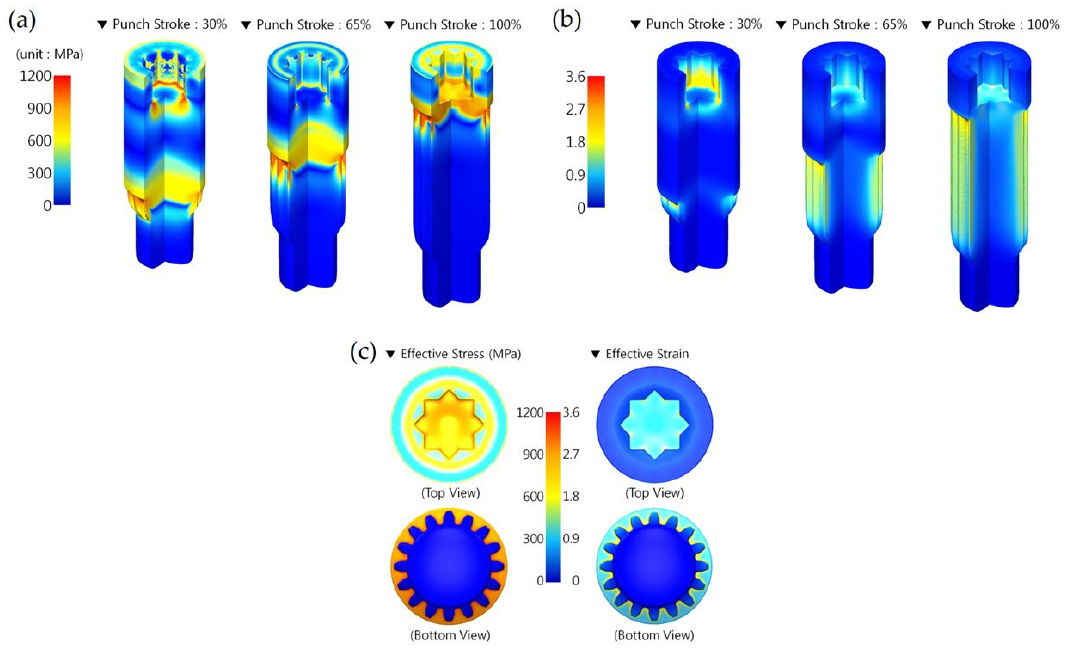
Figure 8. Effective stress and strain distributions obtained from forward-backward extrusion simulation: ( a ) Effective stress distribution with punch strokes of 30%, 65%, and 100%; ( b ) Effective strain distribution with punch strokes of 30%, 65%, and 100%; ( c ) Top and bottom views with punch stroke of 100%.